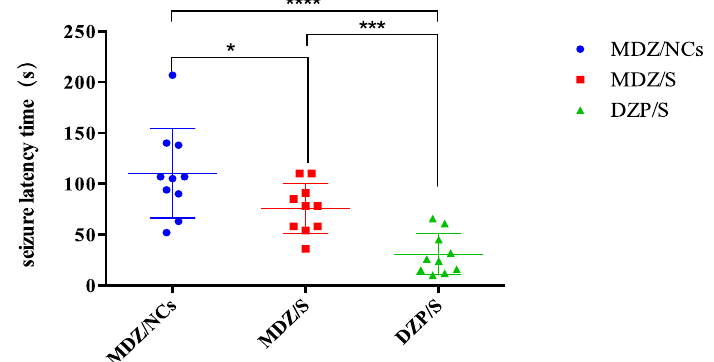
Figure 10. Convulsion latency time of the different formulations. Note: **** p < 0.0001, MDZ/NCs vs. DZP/S; *** p < 0.005, MDZ/S vs. DZP/S; * p < 0.05, MDZ/NCs vs. MDZ/S. Molecules 2020 , 25 , 1080